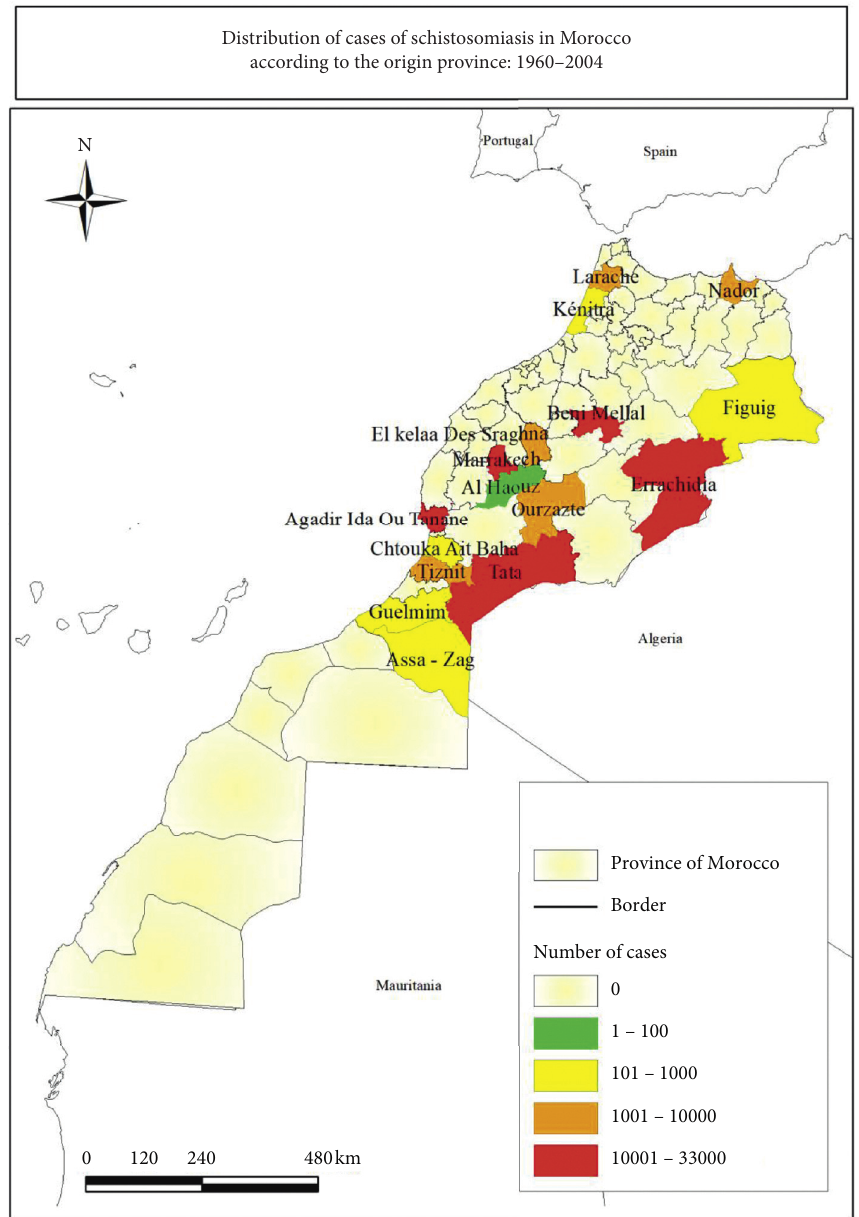
Figure 3: Distribution of cases of schistosomiasis in Morocco according to the origin province: